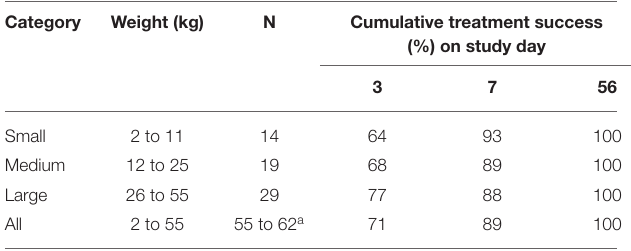
TABLE 6 | Cumulative Cytopoint treatment success for small, medium and large